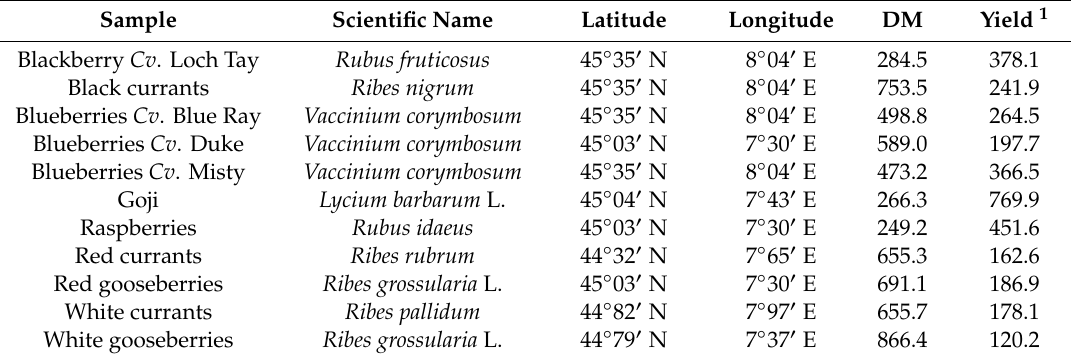
Table 1. Scientific name, area of cultivation, dry matter (DM, g / kg fresh matter) and extract yield of the